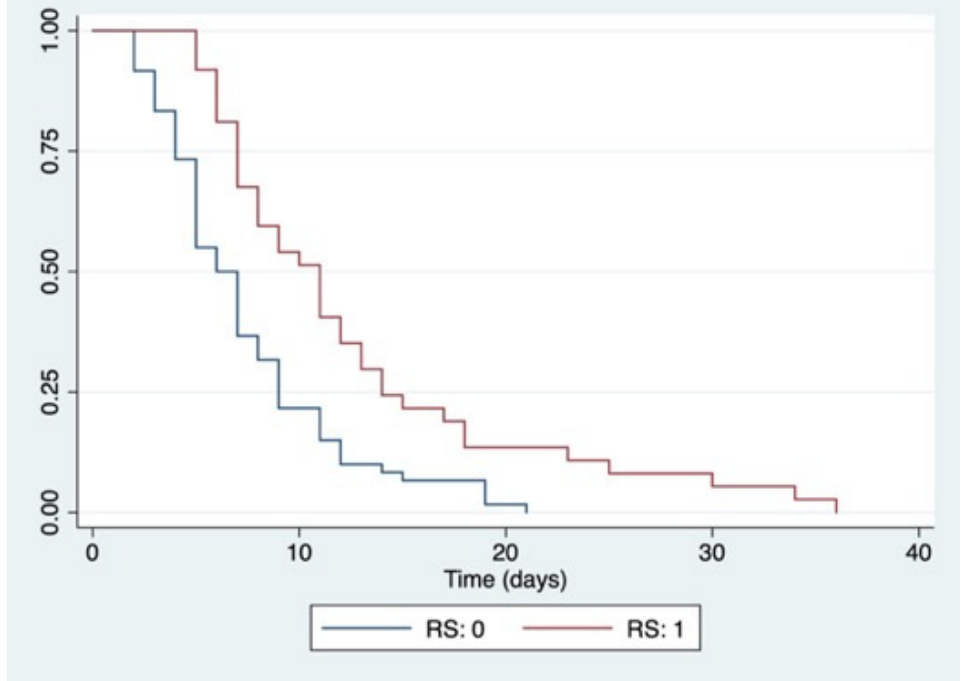
Figure 2. Kaplan–Meier curves for LOS according to RS development. Abbreviations: RS: 0, no development of refeeding syndrome; RS: 1, development of refeeding syndrome; log-rank p < 0.0001. The principal factors associated with a high LOS are resumed in Table 3. In